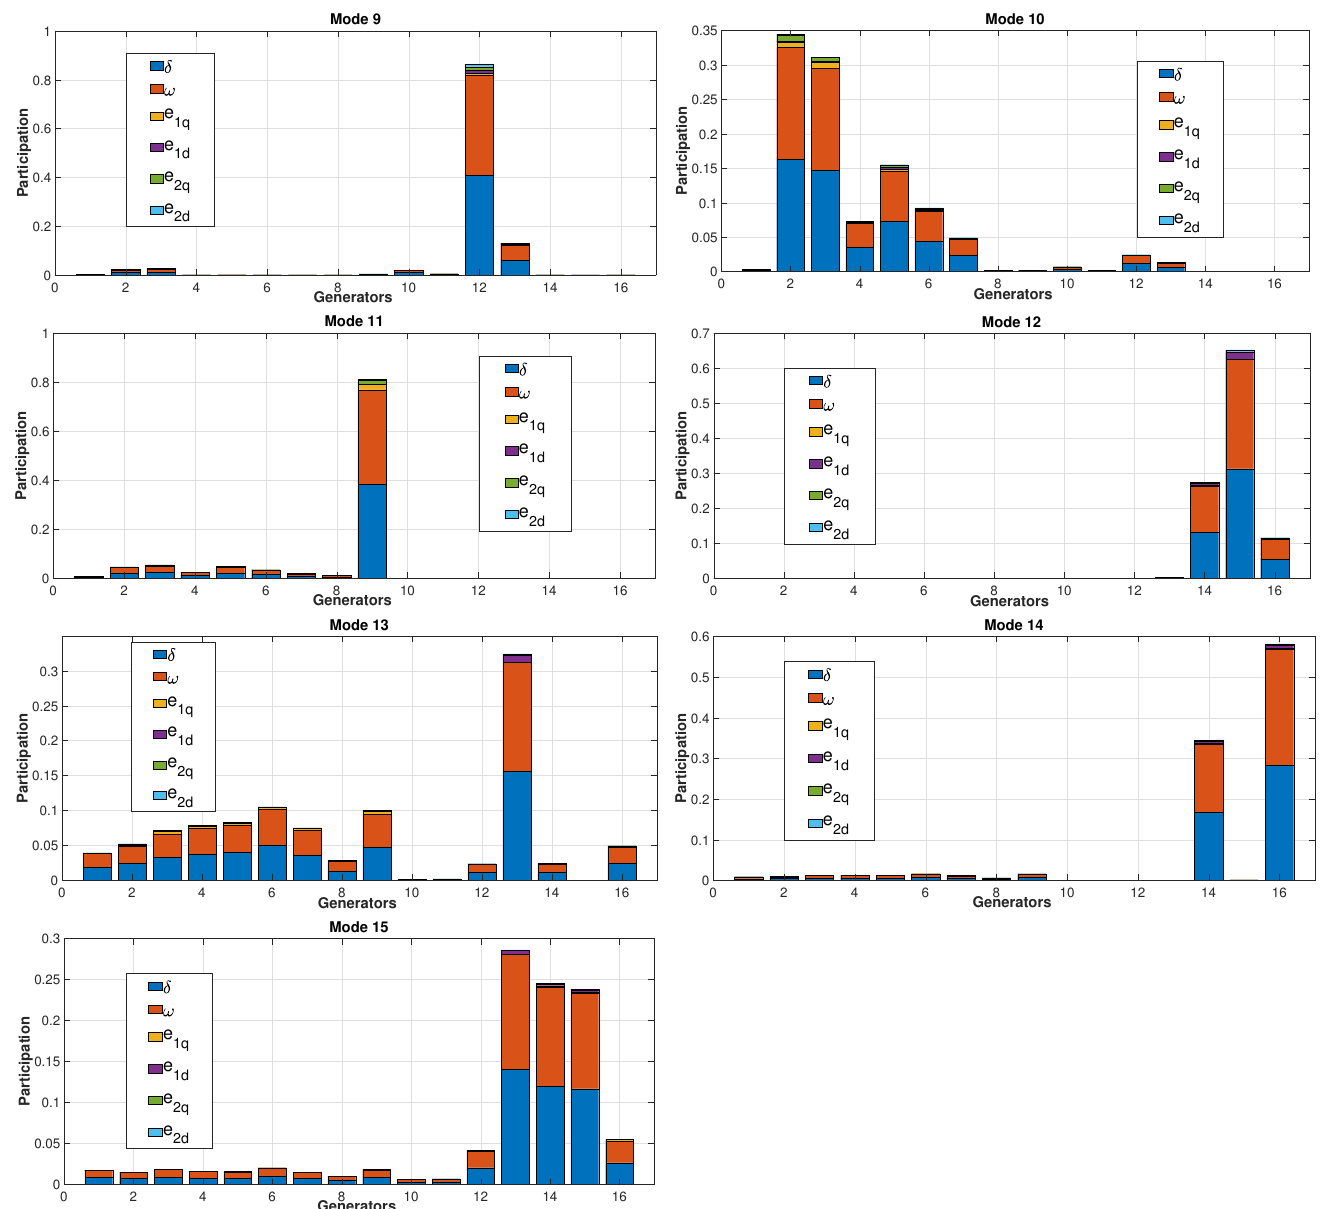
Figure 3. Participation factor information of electromechanical modes in New England 68-bus test